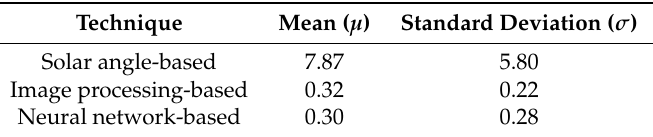
Table 2. Uncertainty analysis.